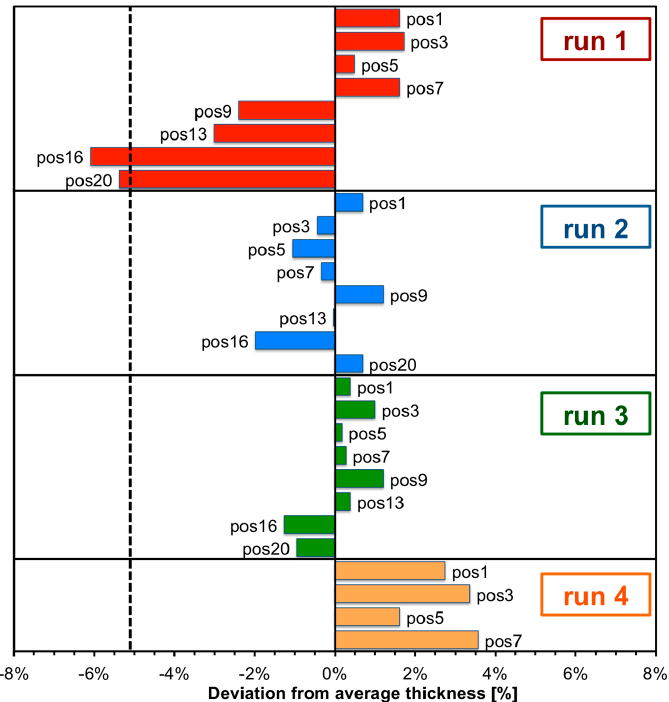
Figure 13. The deviation from the average thickness for the 28 samples. The vertical dashed line indicates the nominal value set by means of the quartz oscillator.